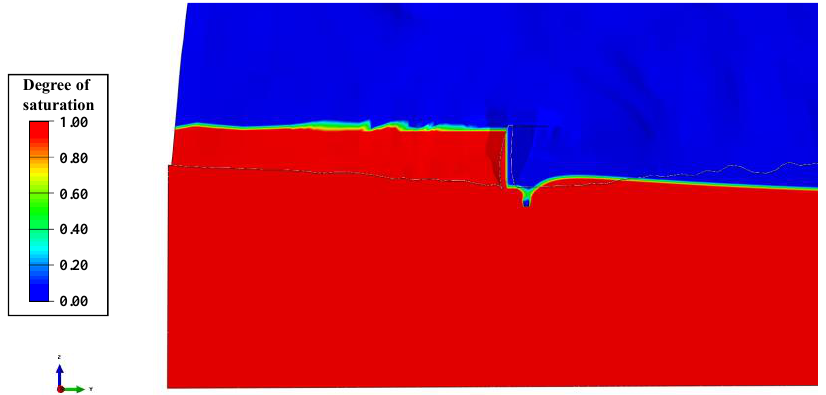
Figure 25. Numerical calculation results of the saturation degree of the third stage of the arch dam’s spillway section (water level: 1880 m).